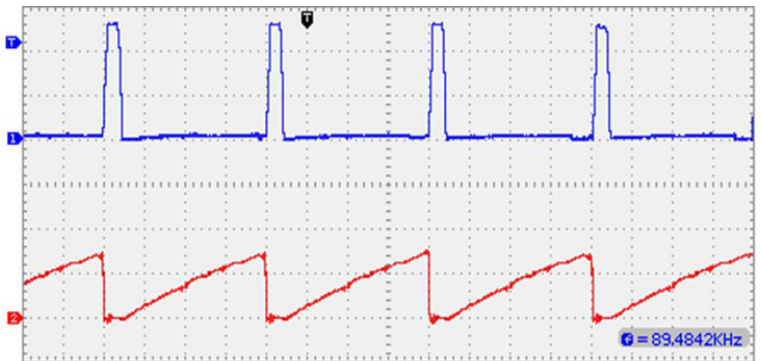
Figure 10. Voltage ( top ) and current ( bottom ) waveforms of switch M 2 (vertical scale 150 V/div or 8 A/div).